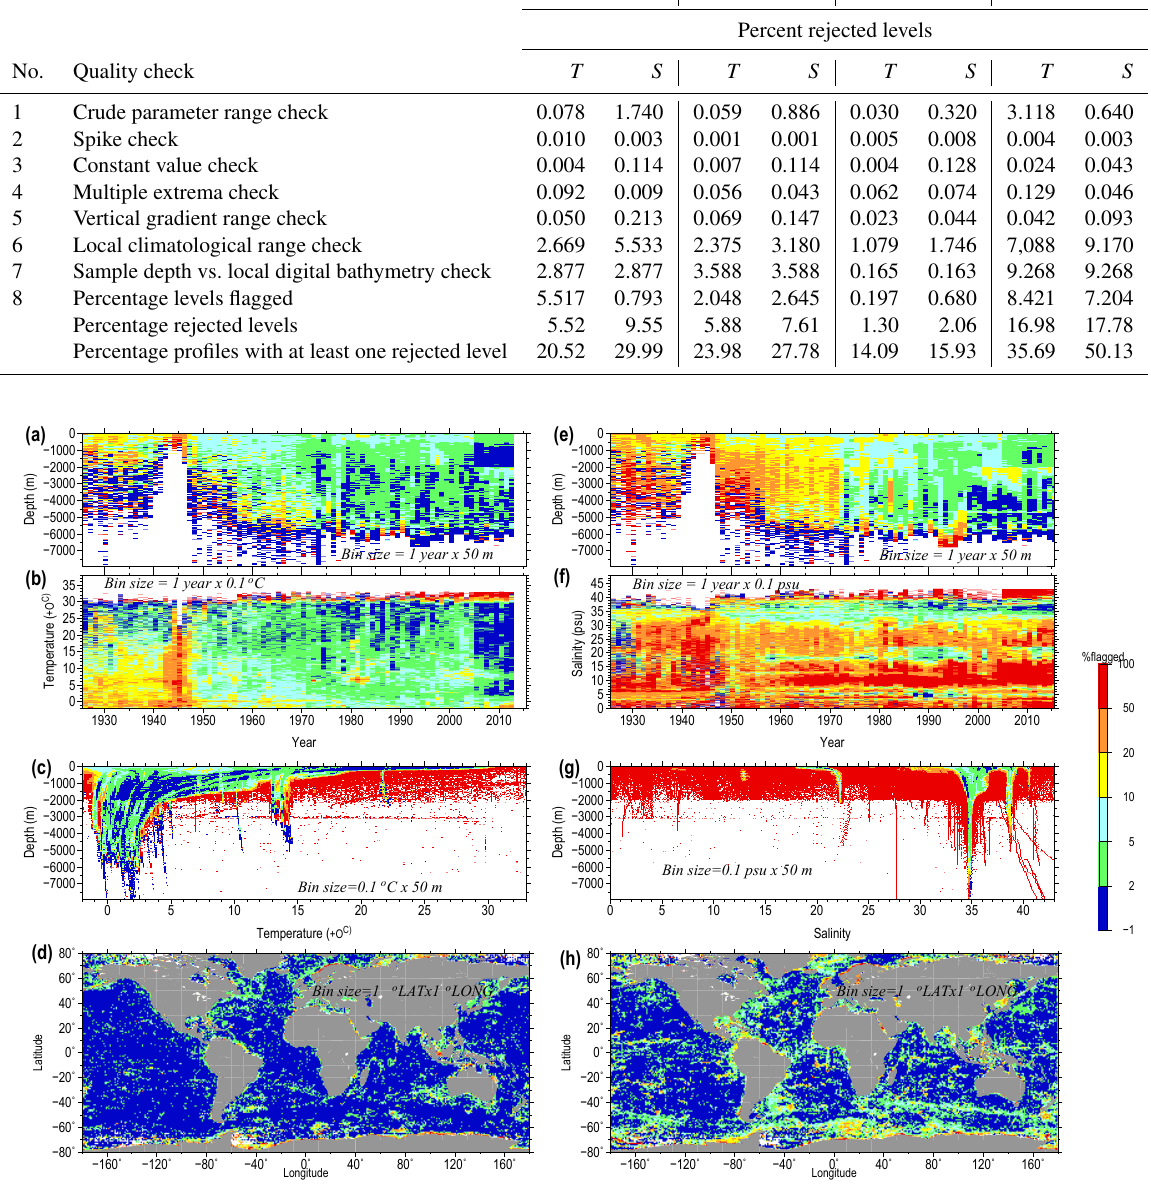
5 Vertical interpolation and extrapolation of the temperature and salinity